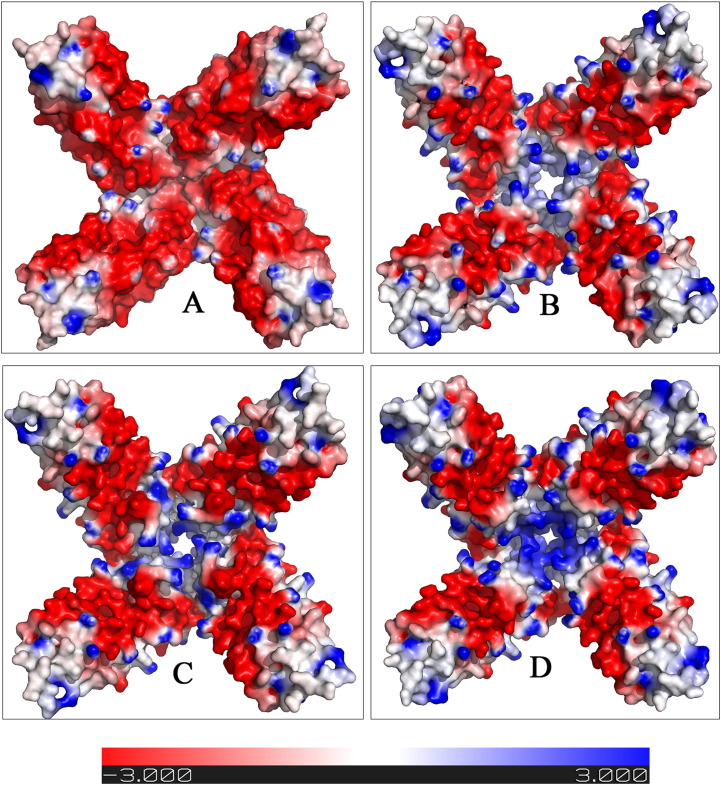
Electrostatic potential distribution of the inner surface of homopolymeric 4 fold axis tetramers. The tetrameric assembly of four identical subunits was reconstructed starting from the wild type FtL subunit (panel A) and the variants p.Arg154LysfsX27, His148ProfsX33 and His148ProfsX33 (panels B, C, D, respectively). In wild type FtL tetramer (panel A), a prevalence of negative charges (red surface) is noticeable and is required for the iron nucleation inside the cavity. All the analyzed variants show an increased distribution of neutral or positive charges (white to blue surface in panels B-C-D) around the four-fold channel, and this can be responsible for a repulsive effect on iron complex. In addition, the reconstruction of the four-fold tetramers showed, for all variants, a wider pore compared to wild type, likely to alter the ferritin shell permeability. The potential scale ranges from − 3kT/e to + 3kT/e from red to blue. The PyMol molecular visualization system (The PyMOL Molecular Graphics System, Schrödinger, LLC) was used for structure visualization, analysis, comparison and for preparation of images.